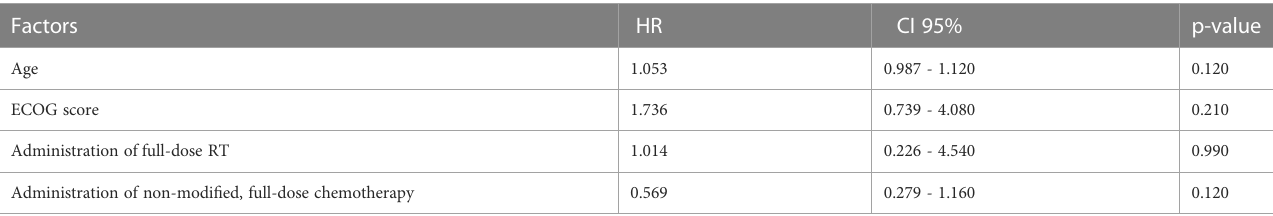
TABLE 3D Multivariate analysis of clinical parameters regarding locoregional control (LRC) of esophageal SCC in elderly patients after de fi nitive or neoadjuvant CRT/RT.